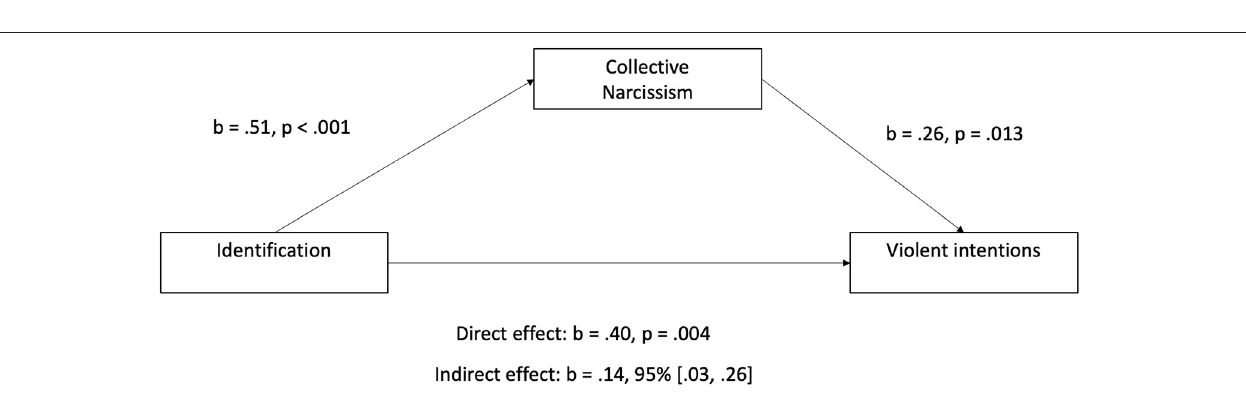
FIGURE 1 | Mediation model of how collective narcissism partially mediates the association between honesty-humility and violent intentions amongst soccer supporters. Estimates are non-standardised estimates. Standardised estimates are presented in the text.